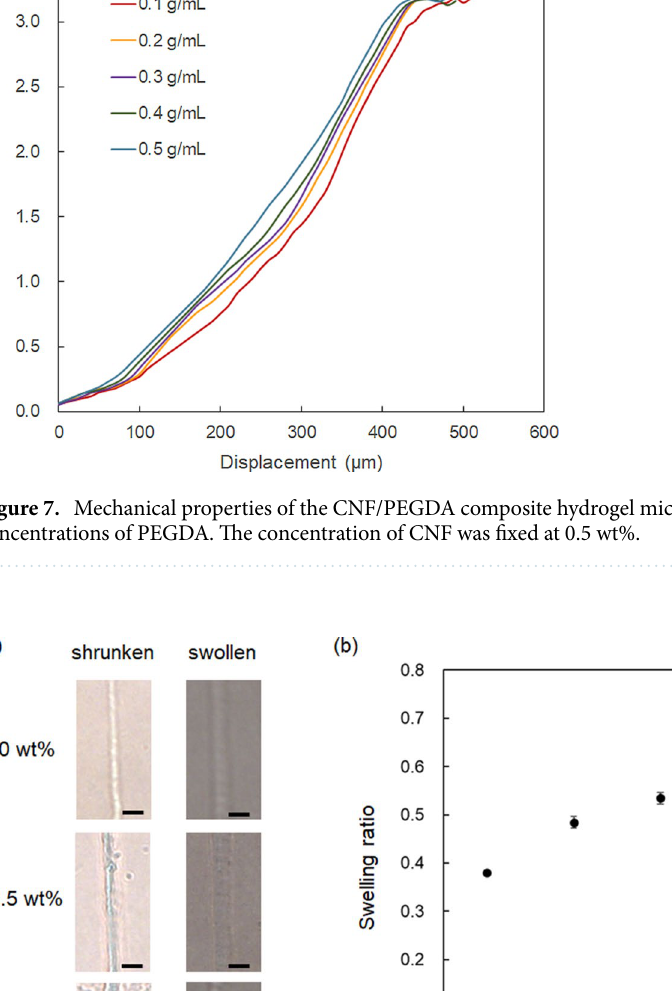
speed of 125 µm/s; the number of scans was 4. The change in the line width caused by shrinkage and swelling